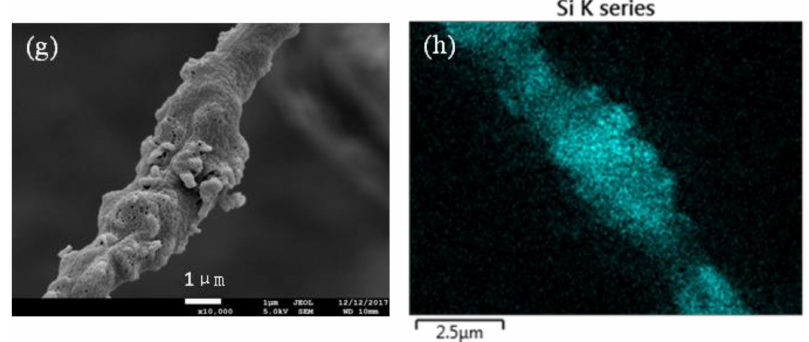
Figure 3. Morphological images of single honeycomb fibers: ( a ) 20% M-P; ( b ) 20% M-P-EDS; ( c ) 40%